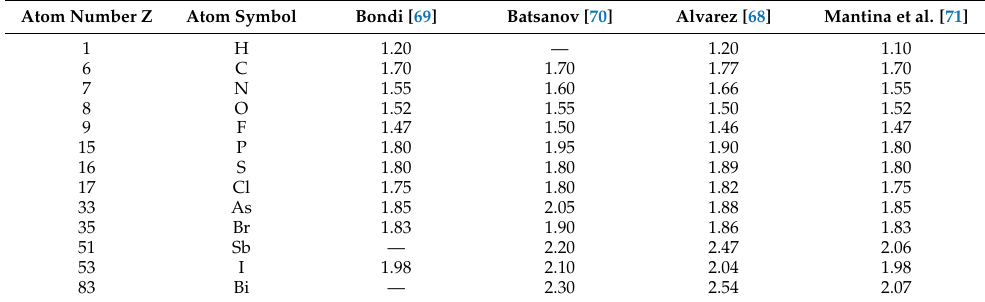
Table 1. The van der Waals radius (Å) of some selected atoms proposed by different authors. Atom Number